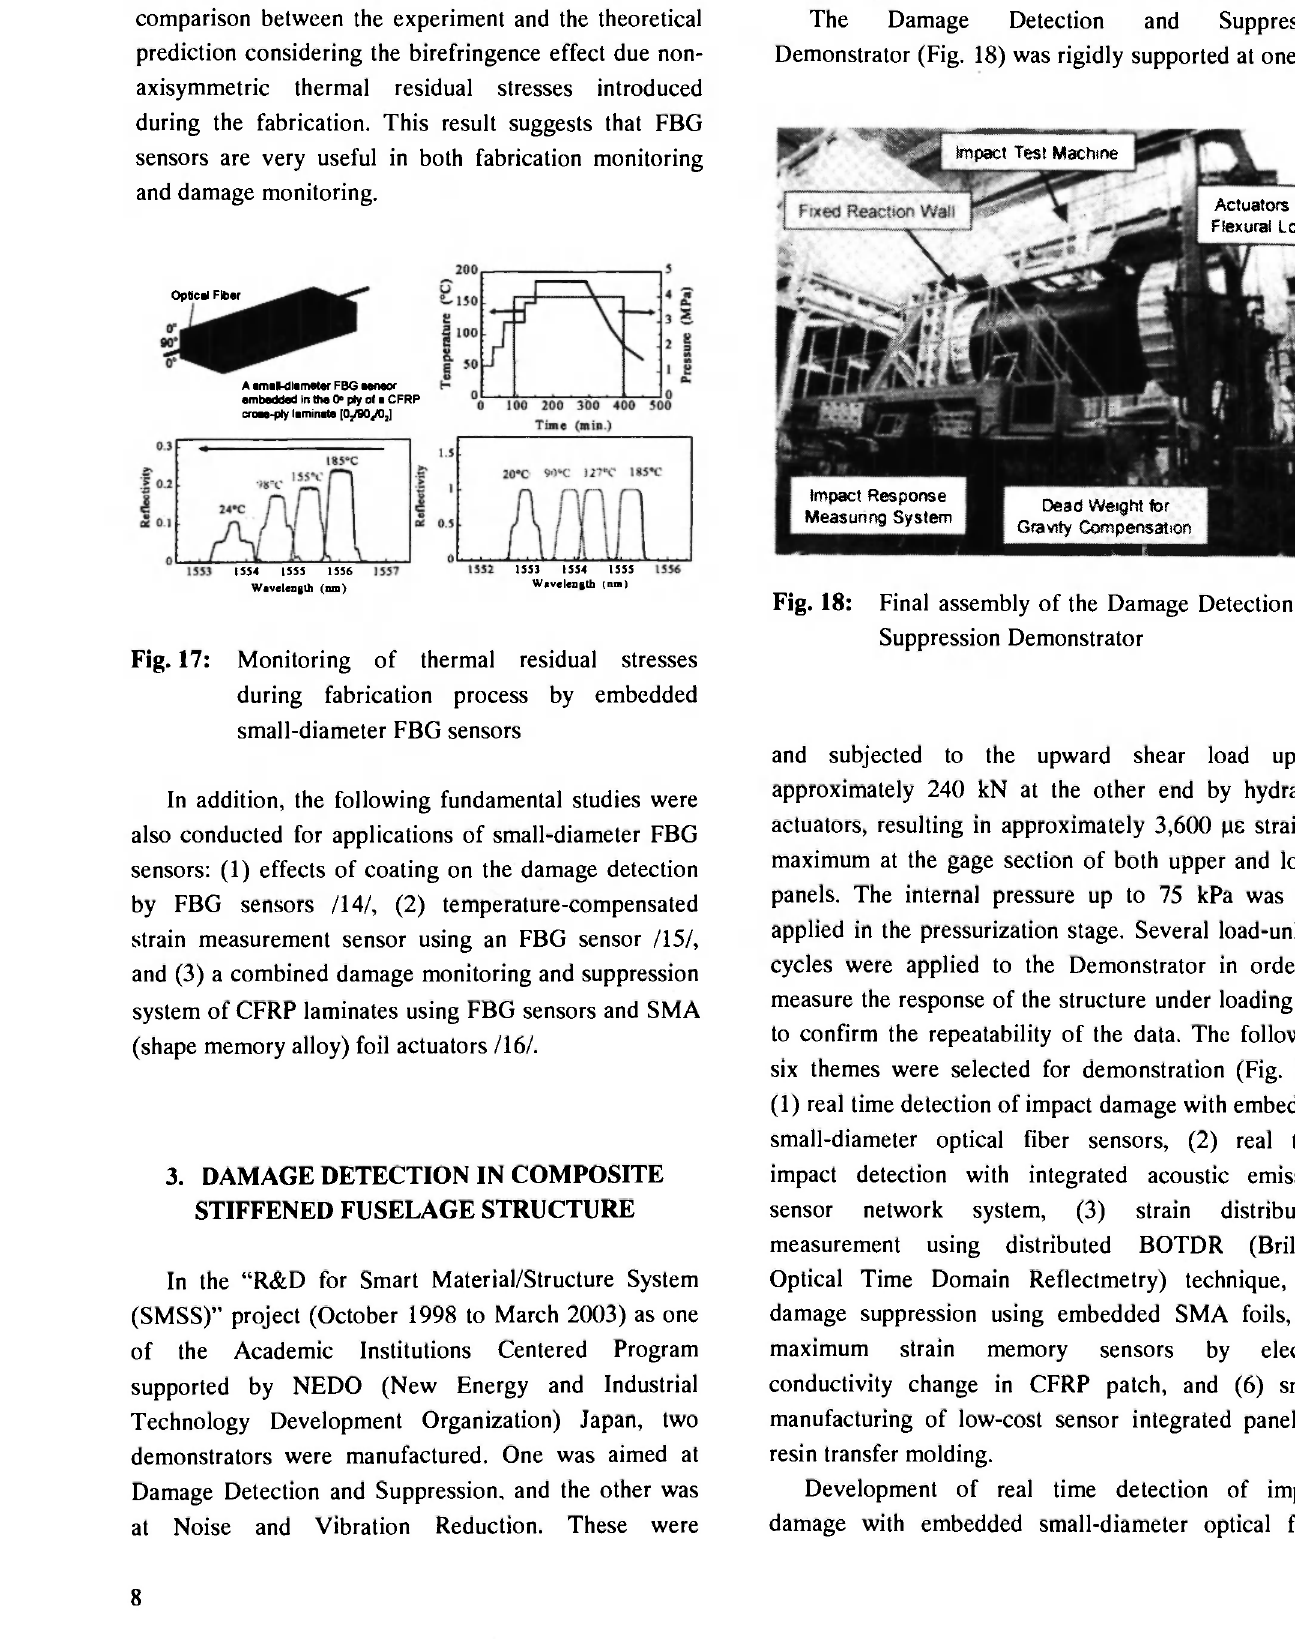
Fig. 18: Final assembly of the Damage Detection and Suppression Demonstrator and subjected to the upward shear load up